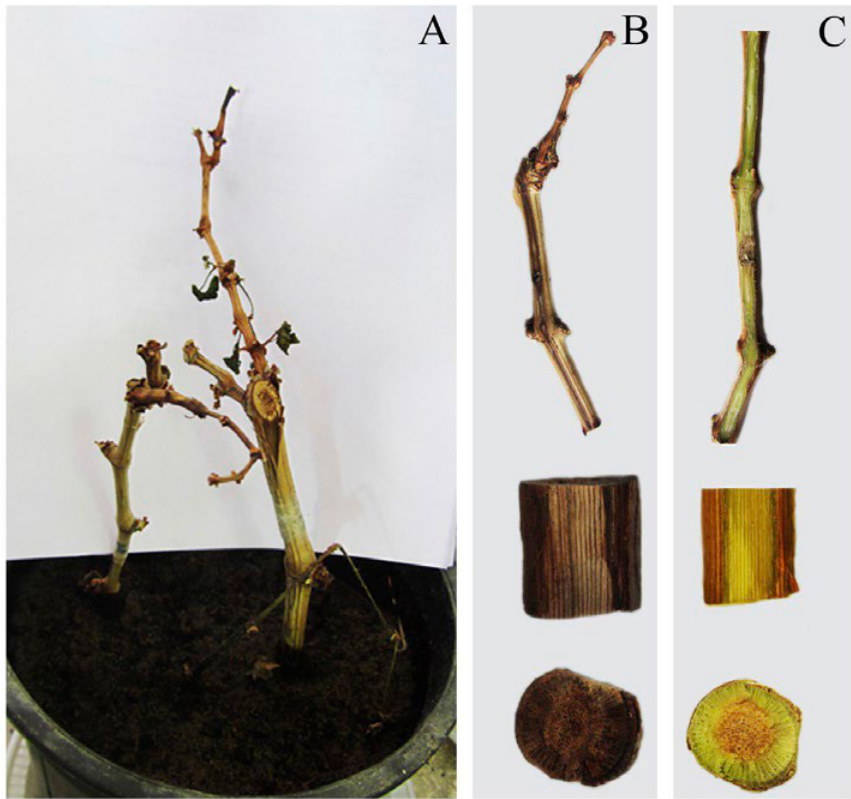
Figure 3. A. Pathogenicity assay of Macrophomona phaseolina on 2-year-old shoots of ‘Keshmeshi’ grapevines (inoculated with M. phaseolina ) . B. Disease symptoms and wood discolouration from an inoculated plant. C. Control (uninoculated) stem with no disease